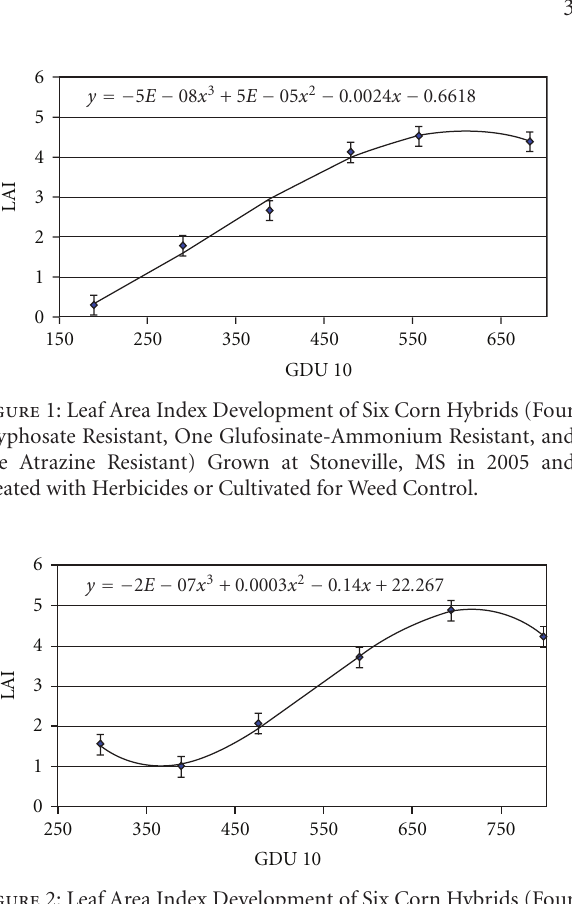
Figure 2: Leaf Area Index Development of Six Corn Hybrids (Four Glyphosate Resistant, One Glufosinate-Ammonium Resistant, and one Atrazine Resistant) Grown at Stoneville, MS in 2006 and Treated with Herbicides or Cultivated for Weed